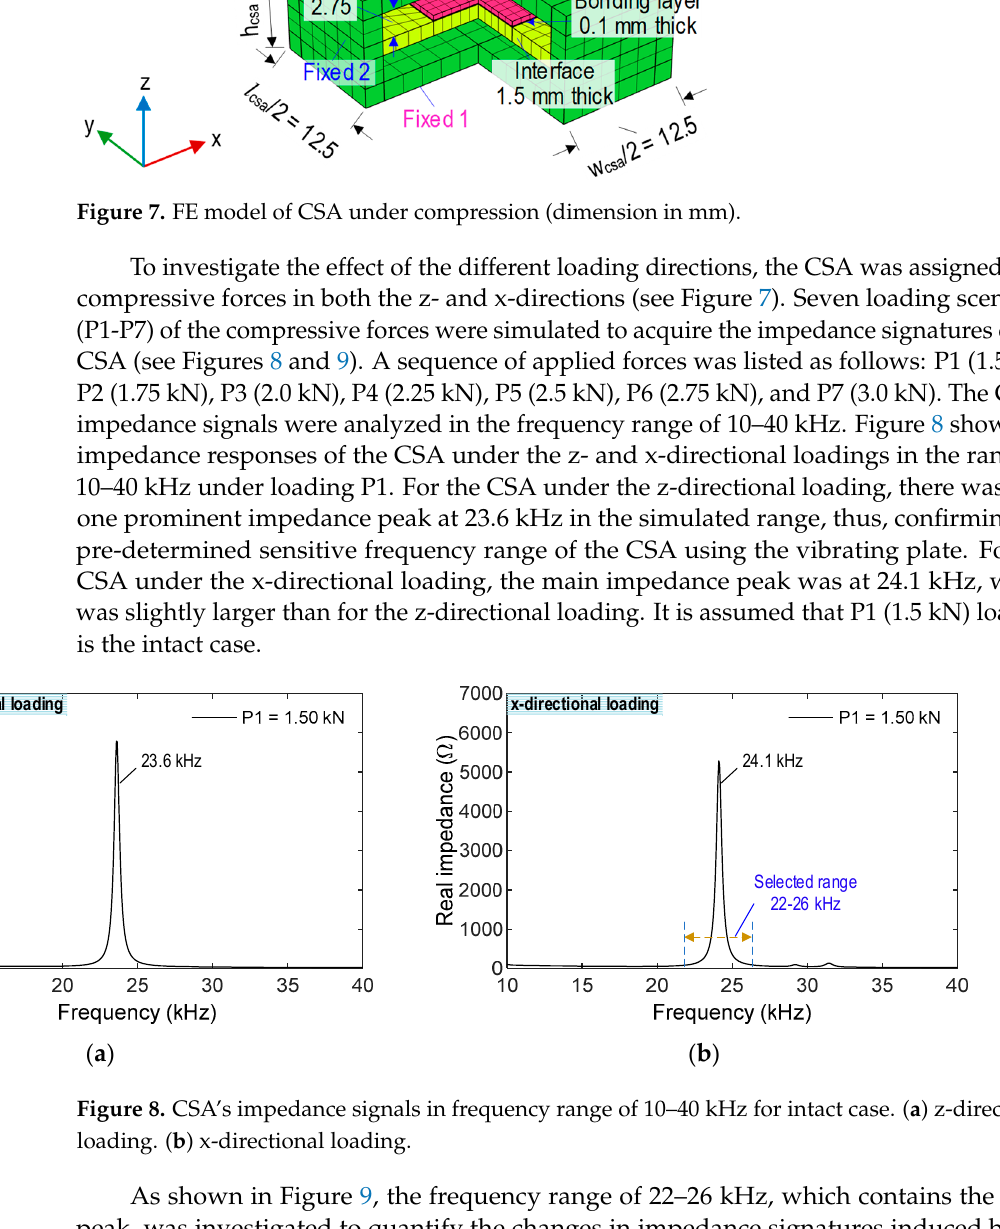
( b ) Figure 9. CSA’s impedance signals in a selected range of 22–26 kHz under loading cases. ( a ) z-di- rectional loading. ( b ) x-directional loading. As shown in Figure 9, the frequency range of 22–26 kHz, which contains the main peak, was investigated to quantify the changes in impedance signatures induced by the changes in compression forces. For the z-directional loading, the impedance signals were shifted to the right under loading cases P1–P7, and they were relatively varied with re- spect to the applied force variations. For the x-directional loading, the impedance signa- tures were shifted to the left under loading cases P1–P7, and they were relatively changed, corresponding to the applied force alterations. The variations in the impedance signals of the CSA under x-directional loading were slightly higher than those under z-directional loading. 3.2.2. Numerical Impedance Features of CSA under Compression To quantify the changes in impedance signals, the RMSD (root mean square devia- tion) index and the CCD (correlation coefficient deviation) index are commonly used as damage indicators for the characterization of structural damage. The RMSD index is computed as follows [6]: